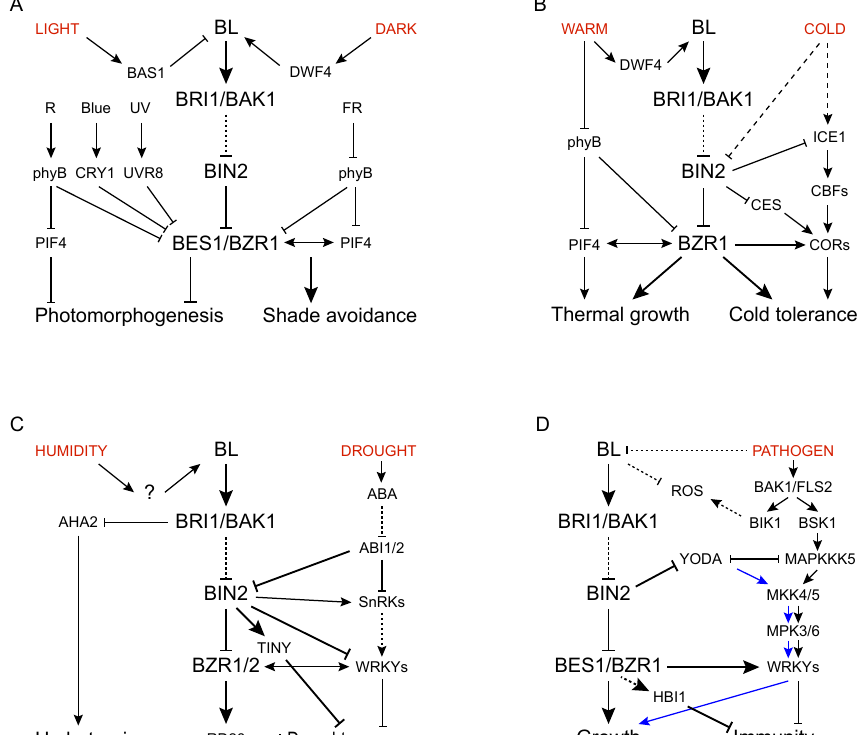
Figure 3. Schematic models indicating the contributions of BR biosynthesis and signaling in response to ( A ) light, ( B ) temperature, ( C ) water availability, and ( D ) pathogens. Arrows indicate activation, whereas lines with blunt ends represent